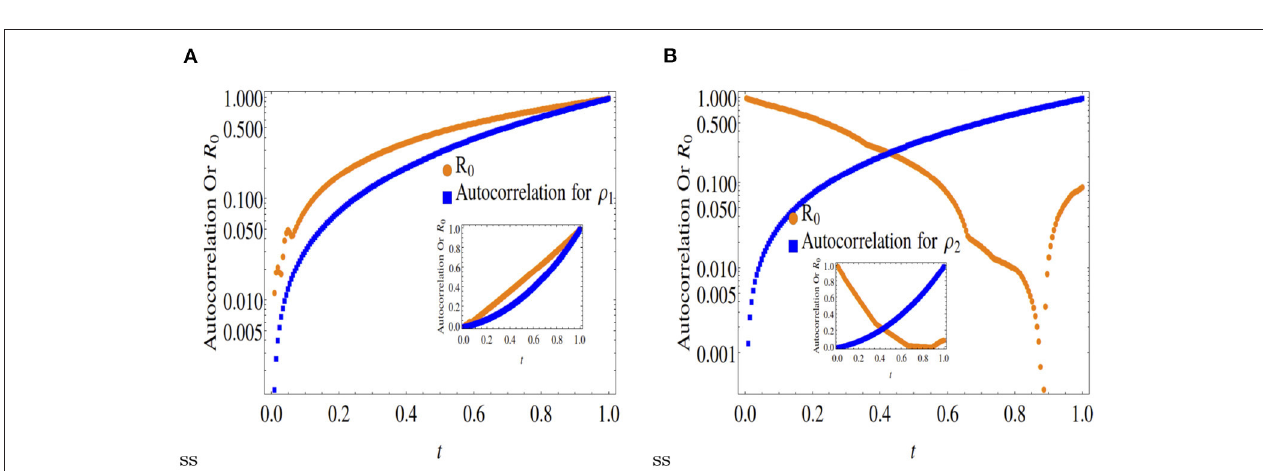
FIGURE 2 | Comparison of normalized autocorrelation and R 0 at x = 0.3. Outset is in log scale and inset is in original scale. (A) Shows that the autocorrelation function and R 0 for the species ρ 1 have the same increasing trend as a function of time. The understanding we get from this trend is that the species ρ 1 is produced fom its own species for long time-scales. (B) Indicates that the dynamics of the species ρ 2 is quite different than ρ 1 . The species ρ 2 is produced from the conversion of ρ 1 instead from its own ancestors, as the R 0 for ρ 2 decreases over